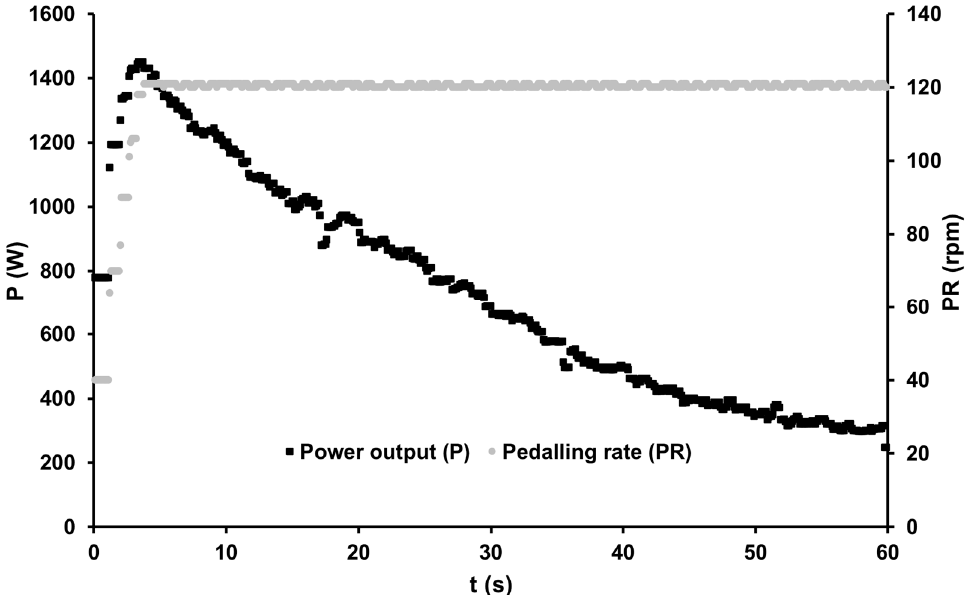
Figure 2. Power output and pedaling rate of an elite male track cyclist during an isokinetic (120 rpm) all-out sprint on an SRM ergometer (sampling rate, 10 Hz).